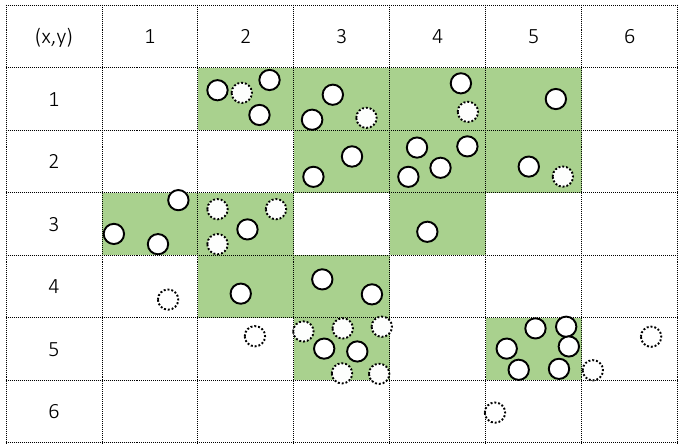
Figure 3. Example of data distribution of a single class and grid formation with 1/6 given for r g against the total x, y length (solid-line circles: target class, dotted-line circles: other class data). Table 1. Data distribution search (DDS)-based selection process.